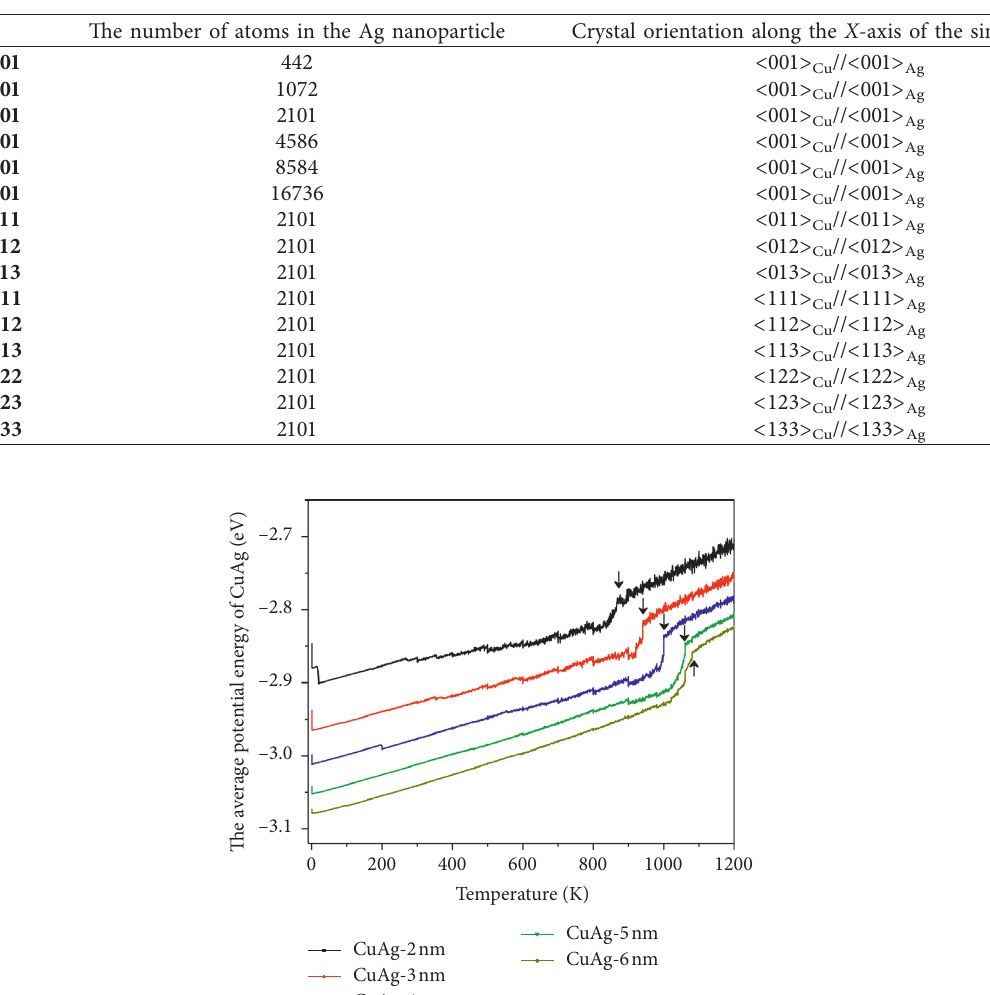
Table 2: Parameters of models for simulation.